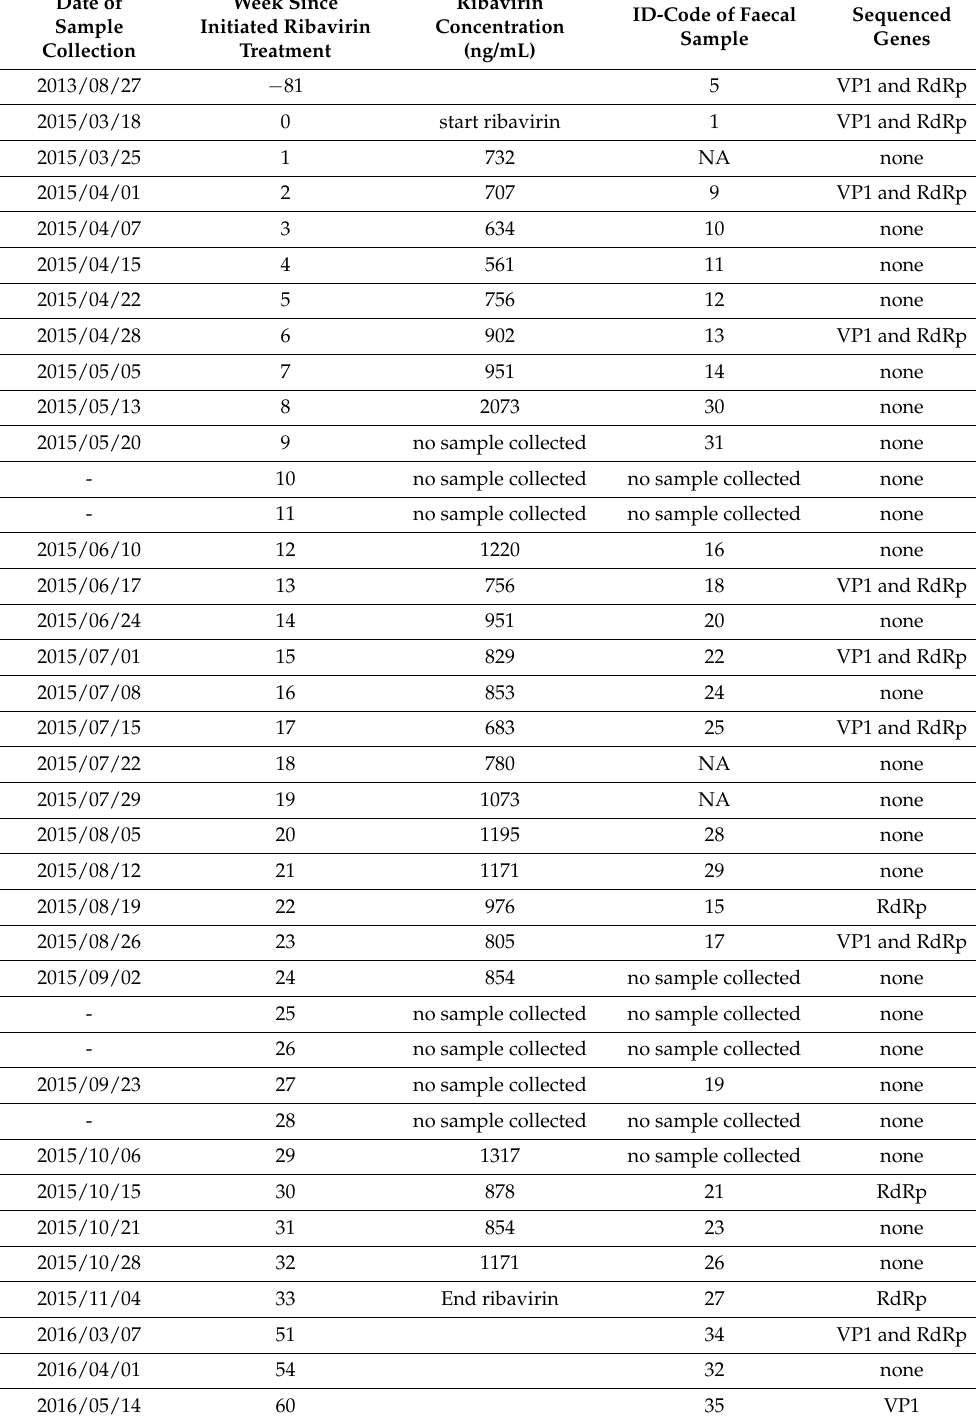
Table 1. Date of sample collection (fecal and/or serum), weeks since start of ribavirin-treatment (minus-symbol used to designate before initiation of treatment), ribavirin concentration in serum, ID-code of faecal sample and if any of VP1 or RdRp gene or both were sequenced successfully. The target concentration of ribavirin was 1000 ng/mL. No sample collected: sample collection was not possible. NA: sample collected and analyzed for norovirus by qPCR but not available for